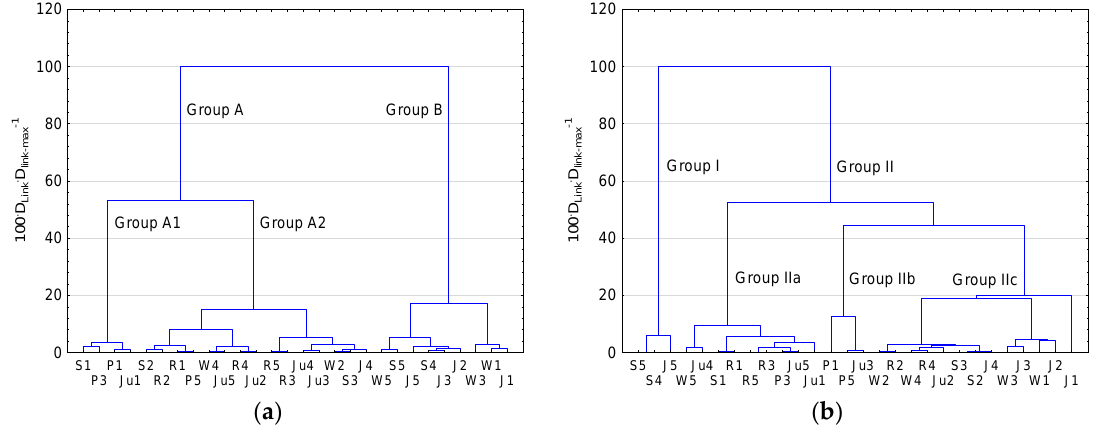
Figure 5. The division of sampling sites into groups by the CA method according to ( a ) the concentrations of HMs; ( b ) sediment texture and TOM content.